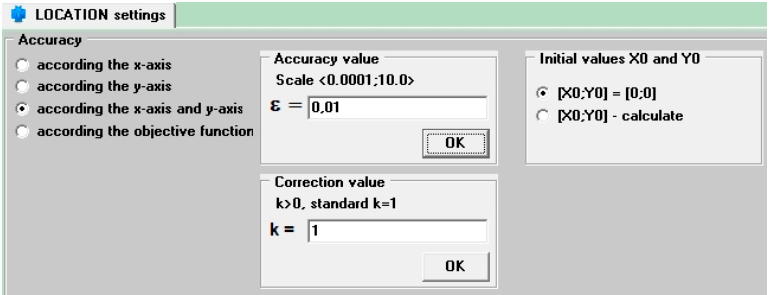
Figure 9. Setting the required location calculation parameters.